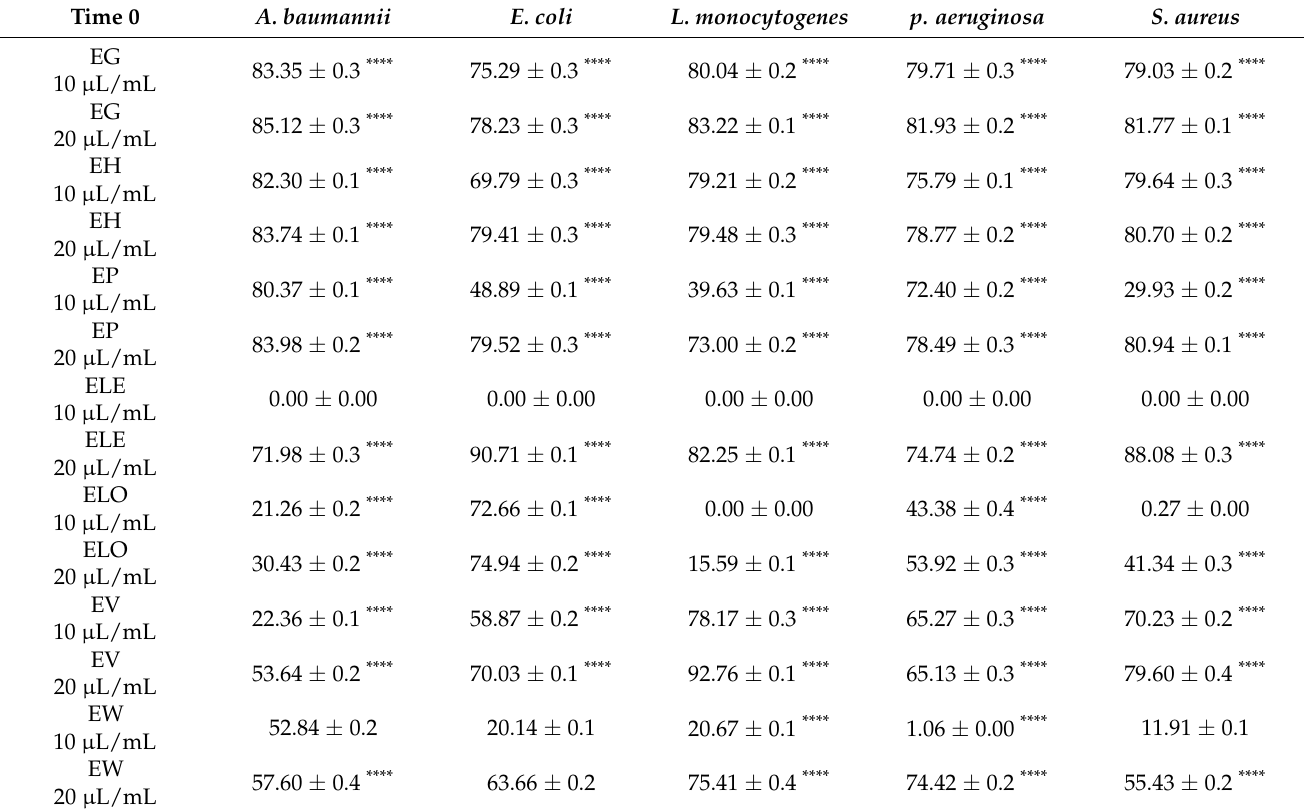
Table 5. Inhibitory activity of the EOs on the metabolism of the bacterial sessile cells in the immature biofilm, at 0 and 24